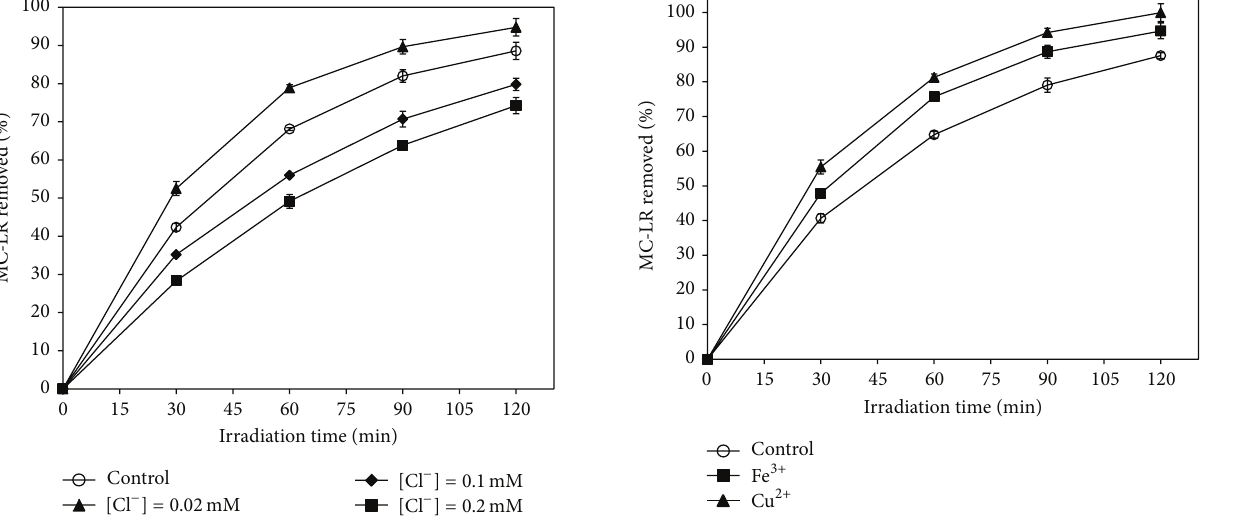
Figure 7: Efficiency of photocatalytic degradation of MC-LR as a function of Cl − concentration. (Experimental conditions: MC-LR concentration of 1mgL −1 , Pt/WO 3 concentration of 100 mgL −1 , and simulated solar light intensity of 0.4 mWcm −2 .)